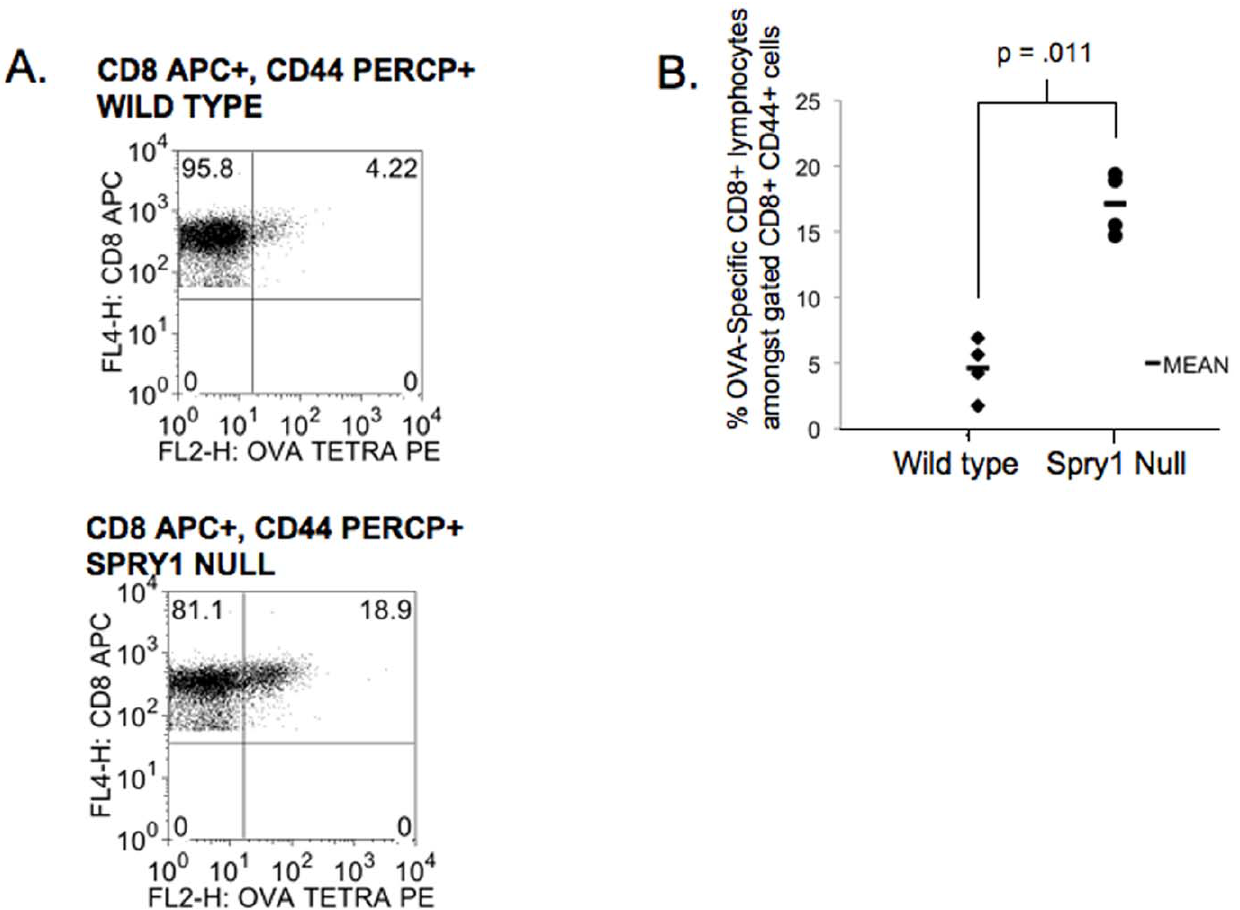
Figure 7. Spry1 null mice have increased percentages of OVA specific CD8 + T cells following vaccination. Wild type and Spry1 null mice were subcutaneously injected with a 1:1 mixture of irradiated EL-4 tumor cells expressing ovalbumin and B16 cells expressing GM-CSF. Seven days later inguinal lymph nodes were isolated and stained with CD8 and ovalbumin specific tetramer. ( A ) Flow cytometric data from lymph nodes of one wild type and one Spry1 null mouse. Gates are set on CD8 + and CD44 + cells. ( B ) Graphical representation of data from four wild type and four Spry1 null mice. P values indicate statistical significance by student t-test. All experiments were performed at least three times.